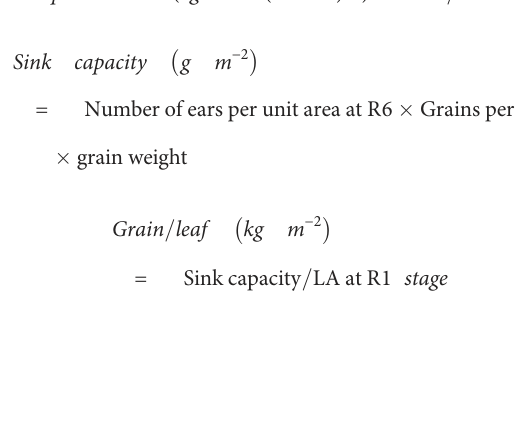
(Table 2). At post-silking, the yield per GDD of DH605